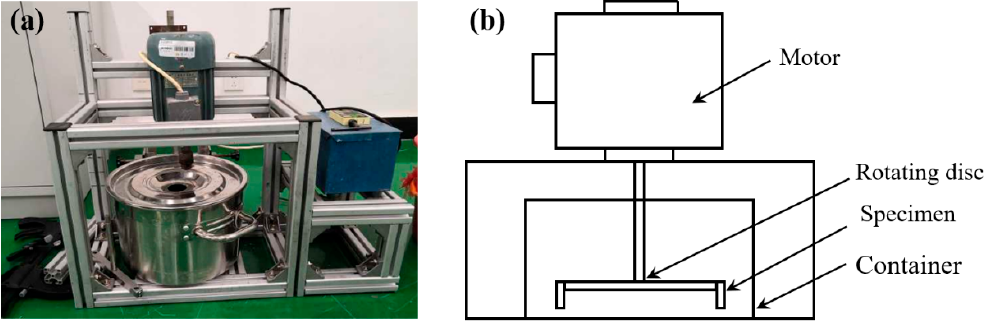
Figure 2. Schematic diagram of rotary erosion wear test device ( a ) physical image, ( b ) schematic